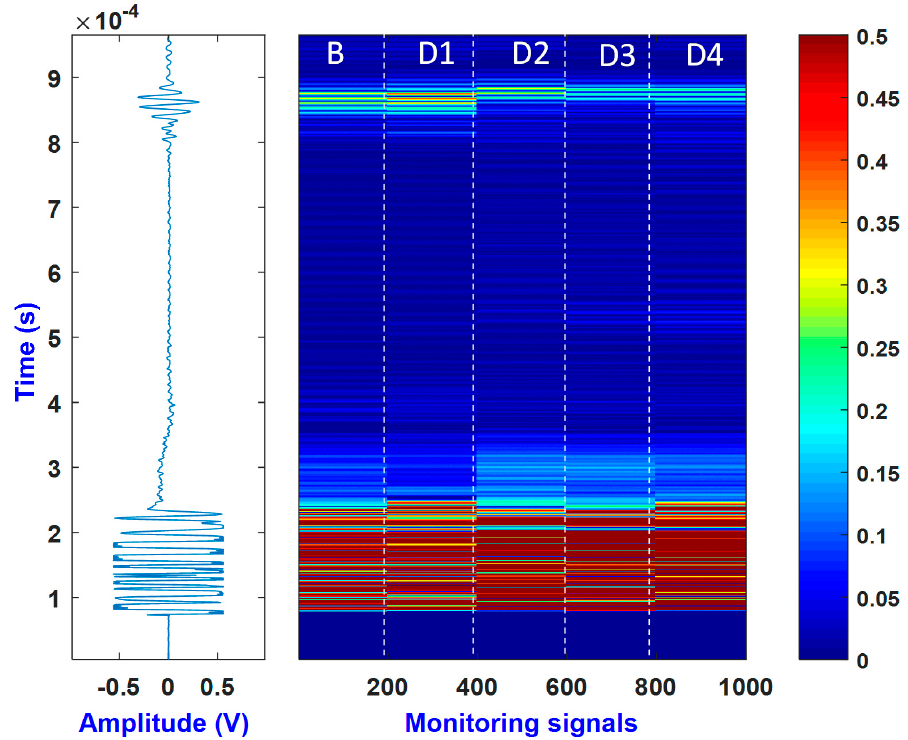
Figure 9. An example of a collected signal (left), and all the collected data (right).